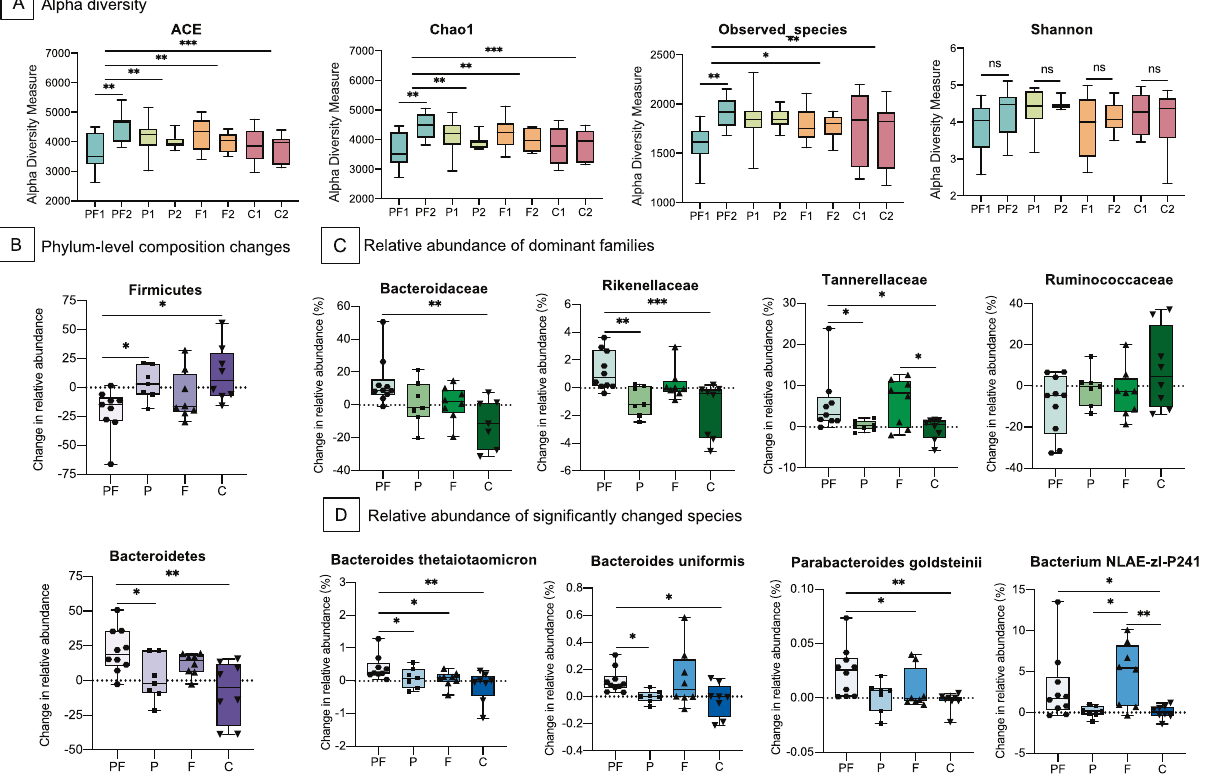
Fig. 2 Gut microbiota changes in four treatment groups. A Alpha diversity evaluated by richness (abundance-basedcoverage estimator [ACE] and Chao1), Observed species, and diversity (Shannon). Boxes indicate interquartile range, lines indicate medians, and whiskers represent range. B Changes in phylum-level composition (Firmicutes and Bacteroidetes) across four treatment groups. C Changes in relative abundance of dominant families acrossfour treatment groups. D Relative abundance of signi fi cantly changed species across four groups. * p < 0.05, ** p < 0.01,*** p <